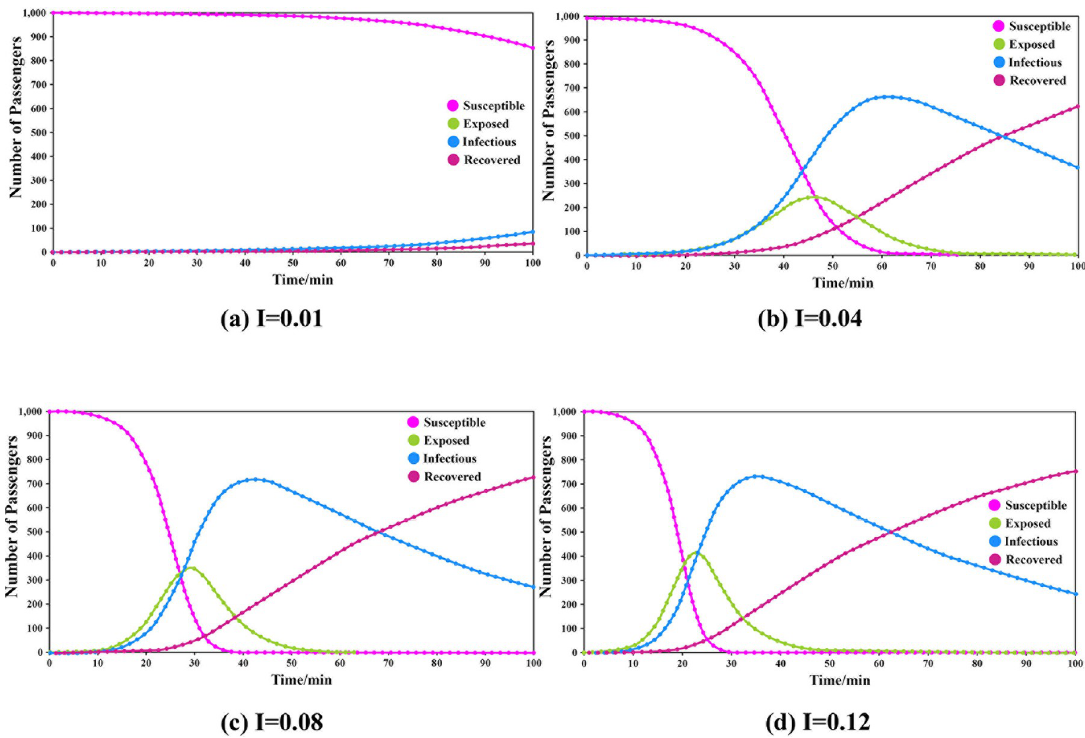
Fig 1. Results of different groups under different conditions of transmissibility.